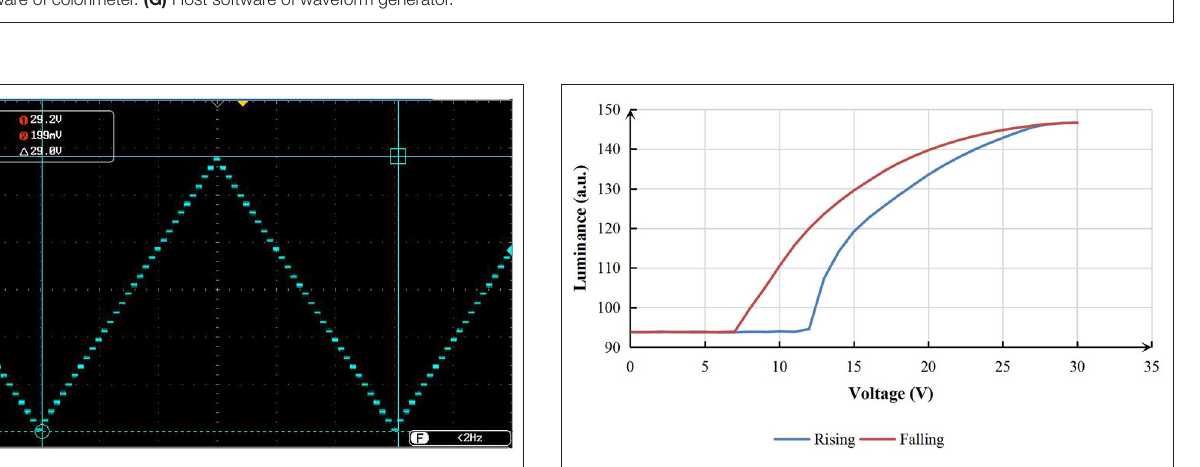
FIGURE 6 | Hysteresis characteristic curve of